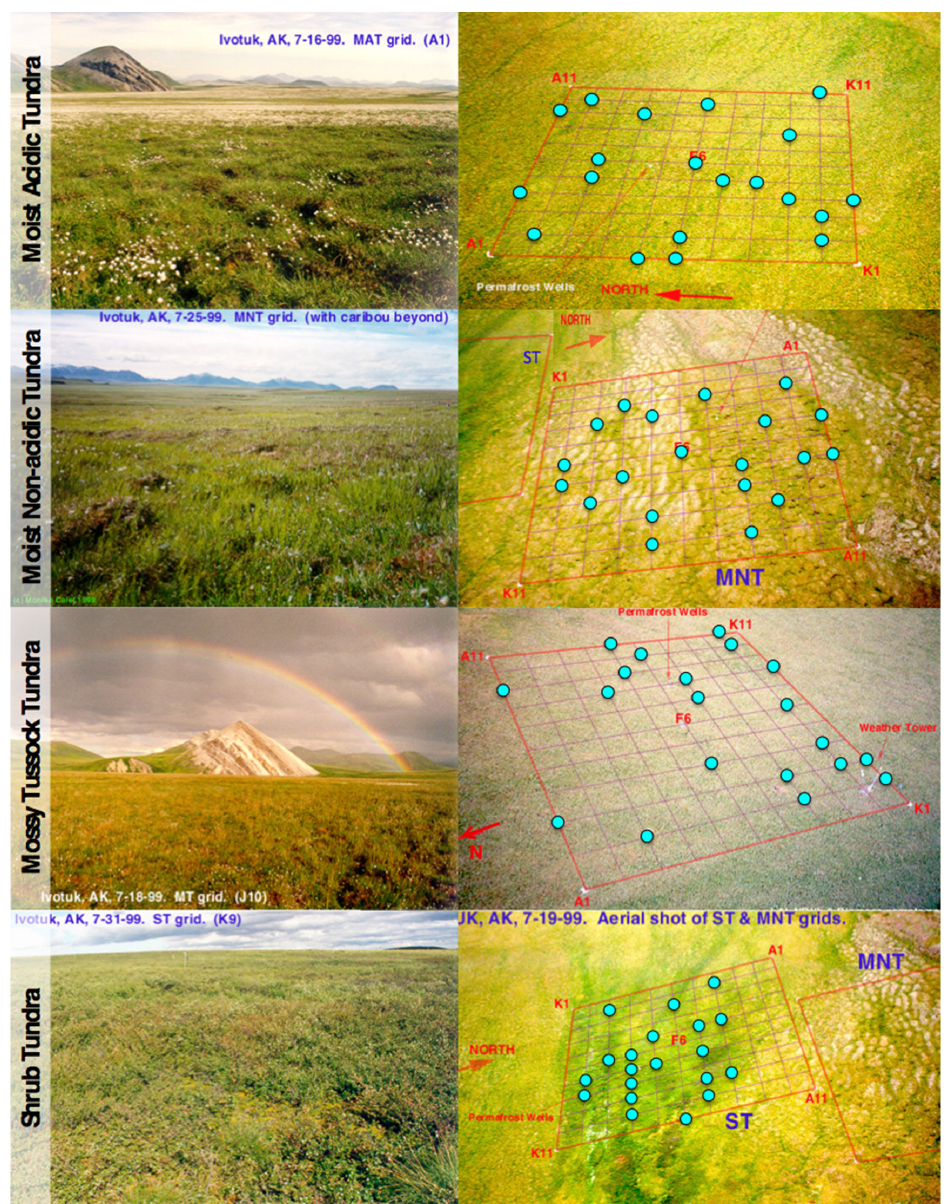
Figure 3. The four vegetation communities at Ivotuk, Alaska along with the grid and spectral sampling locations. Each point represents one sampling gridpoint. Study site images were taken between 16–31 July 1999. All grid images were taken on 19 July 1999 [60]. Table 1. Biomass percentages by plant functional type (PFT) during early (7 June–7 July) and peak (16 July–17 August) growing season at Ivotuk, Alaska.